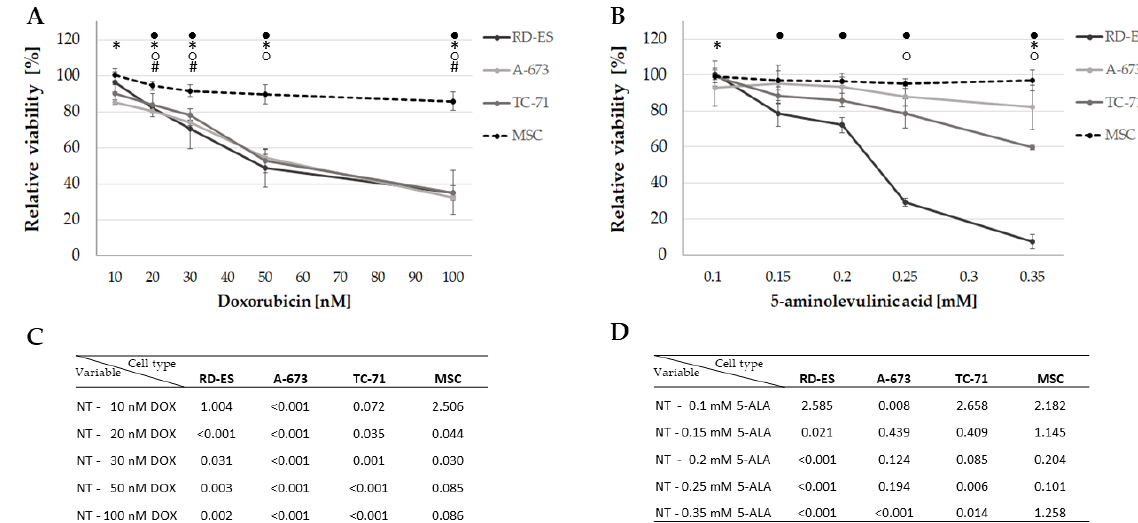
Figure 2. Effect of DOX and 5-ALA PDT on the viability of the ES cell lines and control cells. After 24 h, cells (ES: RD-ES, A-673, TC-71 and MSC) were treated with different concentrations of DOX ( A ) or 5-ALA PDT exposure for 600 sec; ( B ). Negative controls were set to 100% viability and the relative viability was calculated. Mean values were plotted from three independent experiments. Error bars indicate the standard deviations. Statistical significance ( p < 0.05) compared to NT is indicated by • for RD-ES, * for